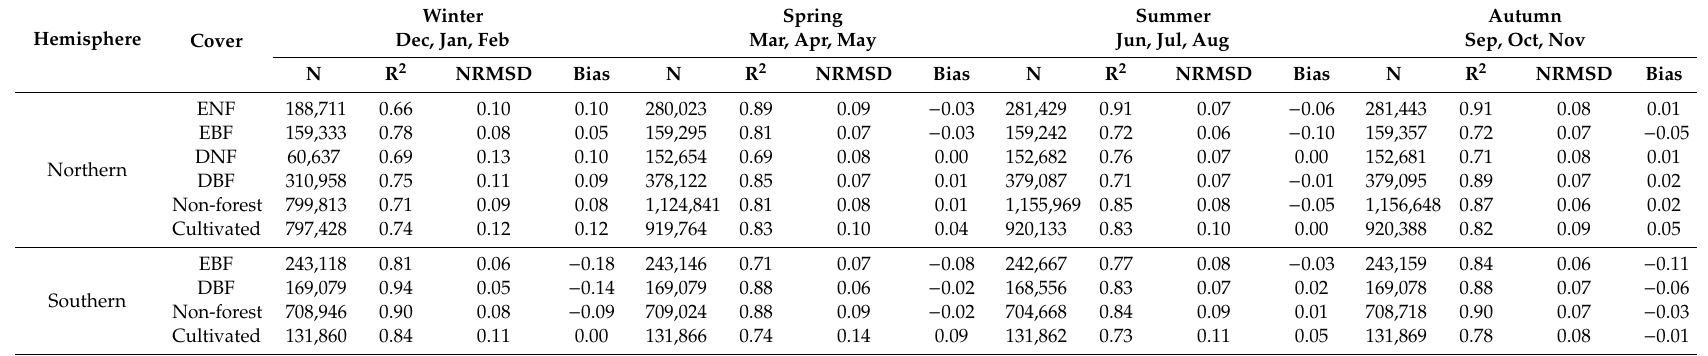
Table 5. Summary statistics per land cover: evergreen needleleaf (ENF), evergreen broadleaf (EBF), deciduous needleleaf (DNF), deciduous broadleaf (DBF), non-forest, and cultivated